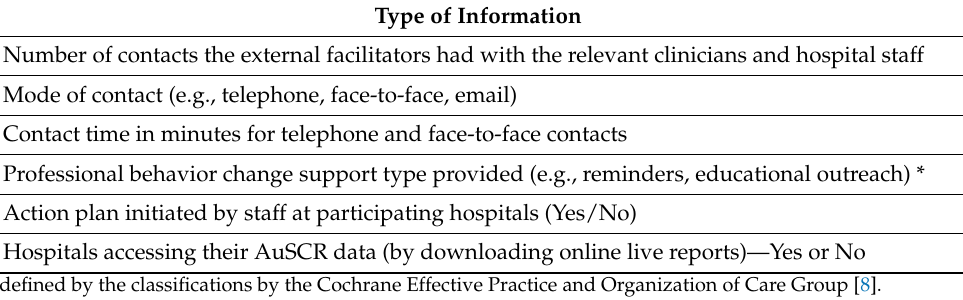
Table 1. Information collected from external facilitators.